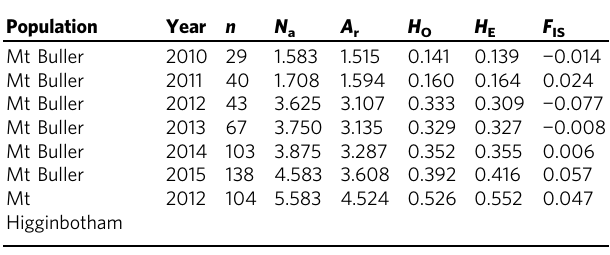
Population genetic statistics for B. parvus based on 24 nuclear microsatellite markers. Sample size ( n ), average number of alleles ( N a ), mean allelic richness ( A r ), mean observed ( H O ) and expected ( H E ) heterozygosity, and the inbreeding coef fi cient ( F IS ). Estimates for a large and stable population in the central region (Mount Higginbotham) are shown as a